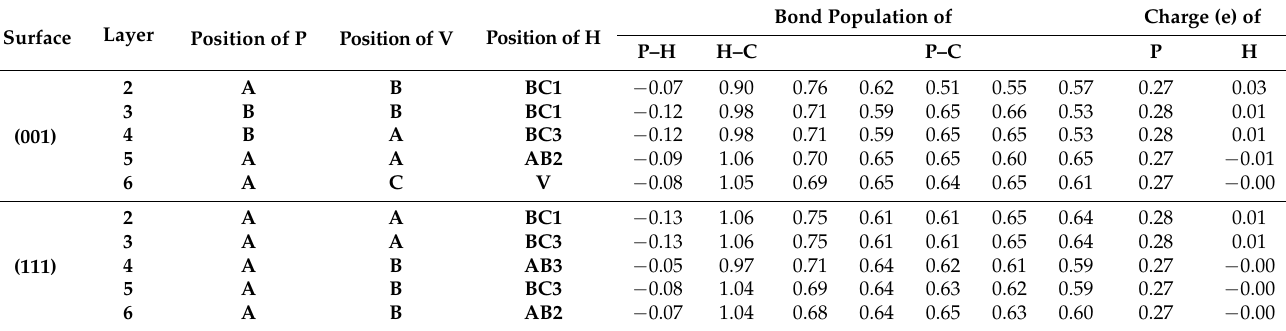
Table 7. Atomic charges and electron bond population of the PVH complex with the lowest formation energy in each layer. Surface Layer Position of